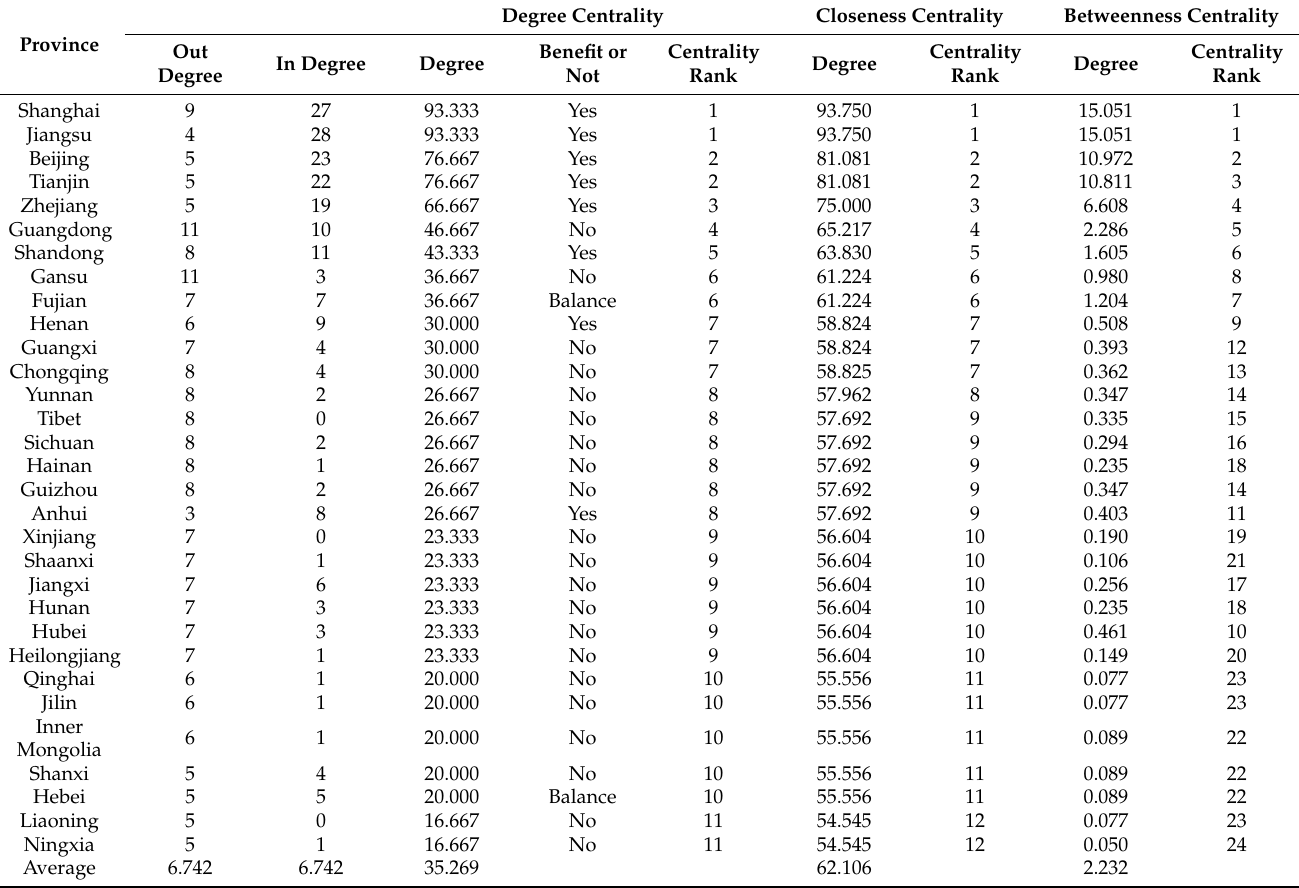
Table 2. The network centrality of the health economic spatial